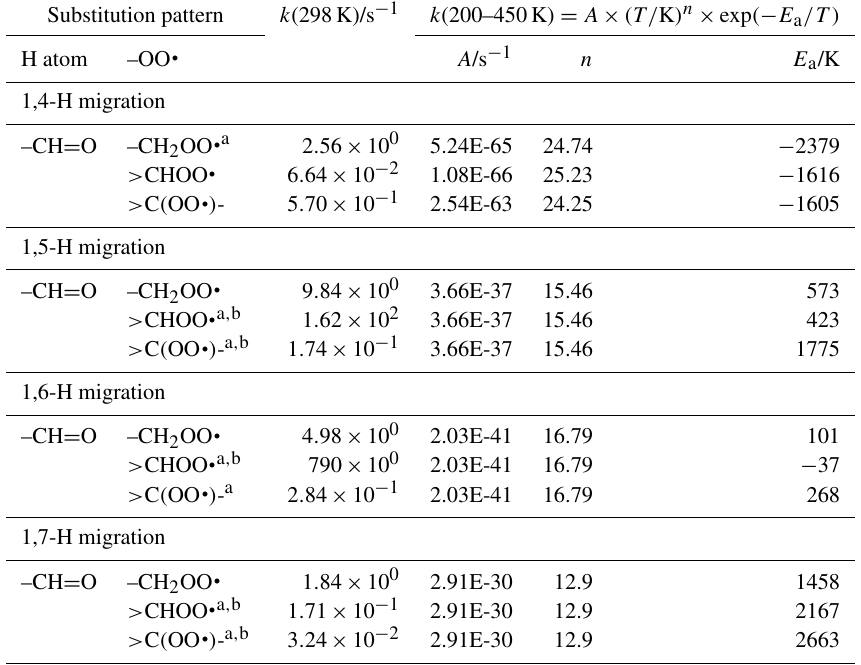
Table 4. Rate coefficients for H migration in aldehydic peroxy radicals. Substitution pattern